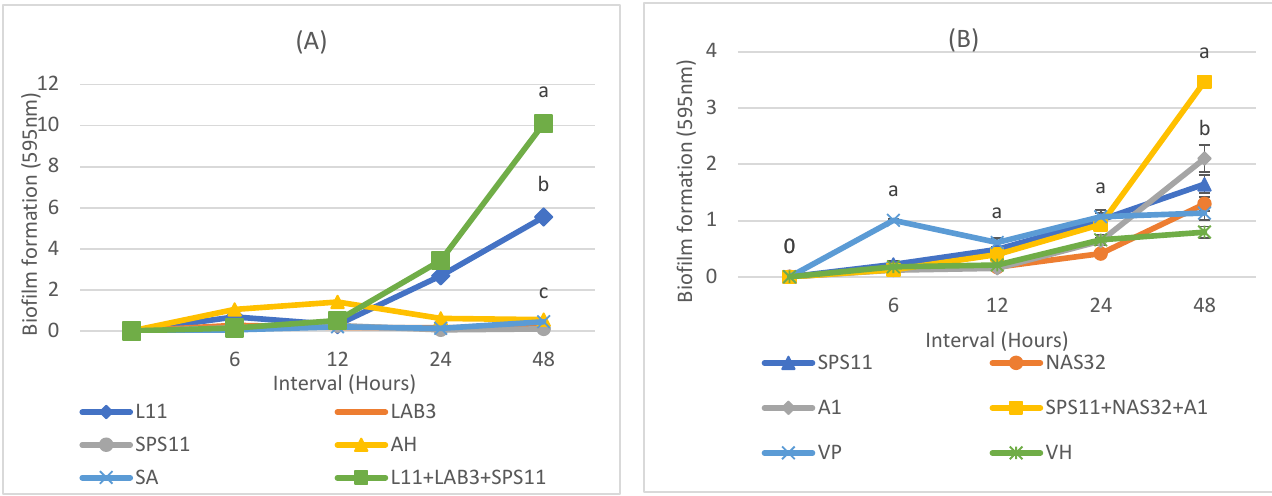
Table 4. Biofilm-forming ability of SSPs, pathogens and MSP2 at different time interval.